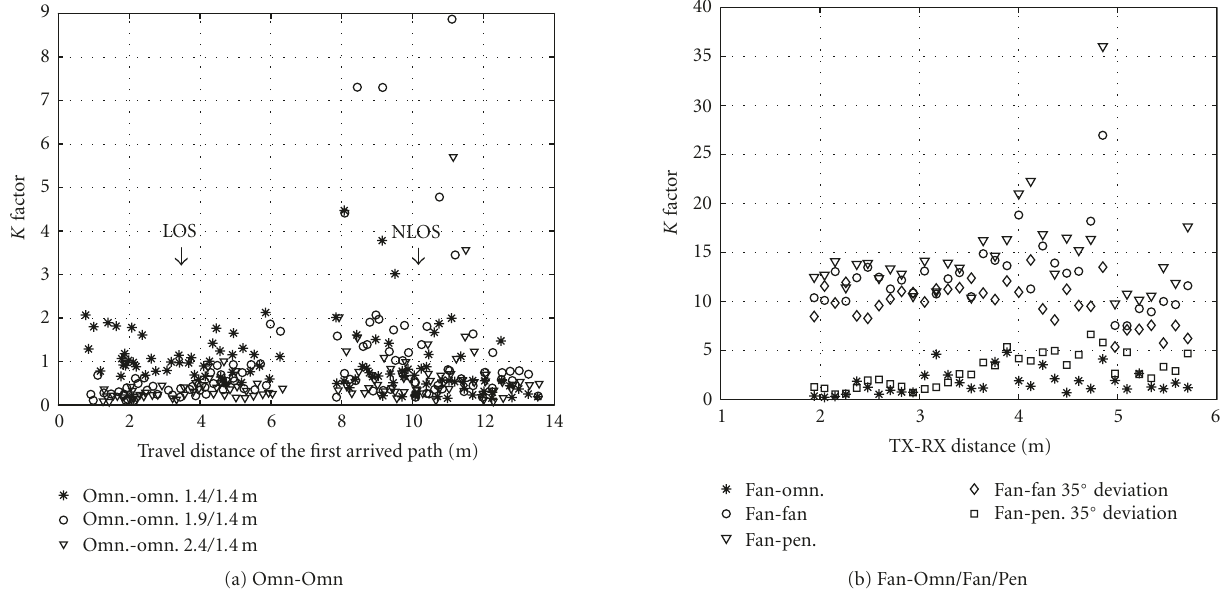
Figure 3: The measured instantaneous K -factor over the travel distance of the first arrived